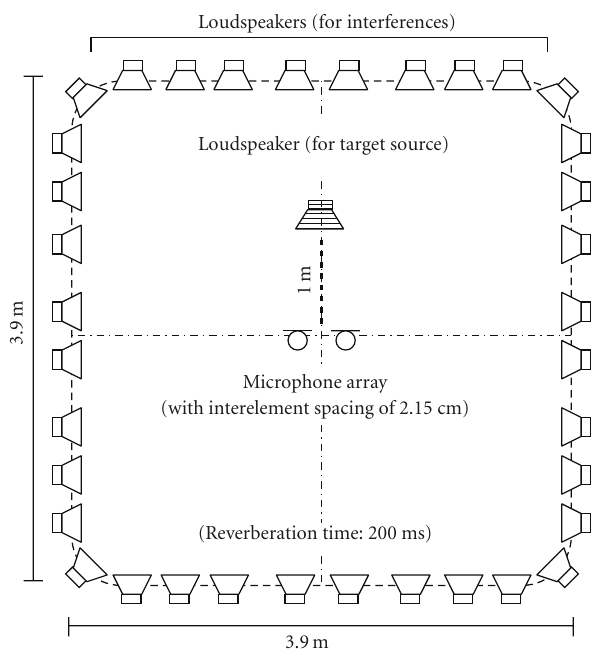
Figure 14: Reverberant room used in our